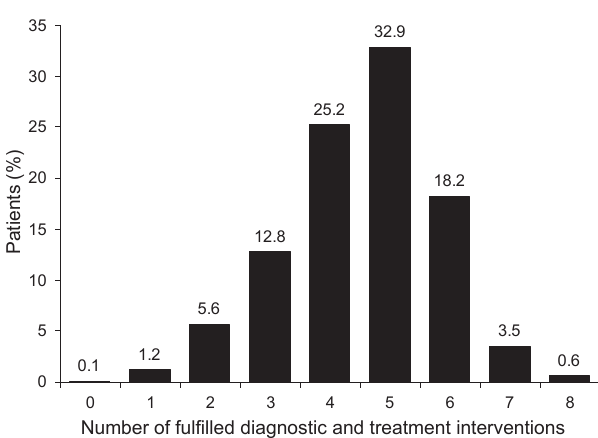
Fig. 2. Number of completed diagnostic and treatment interven- tions in the initial 6 h.